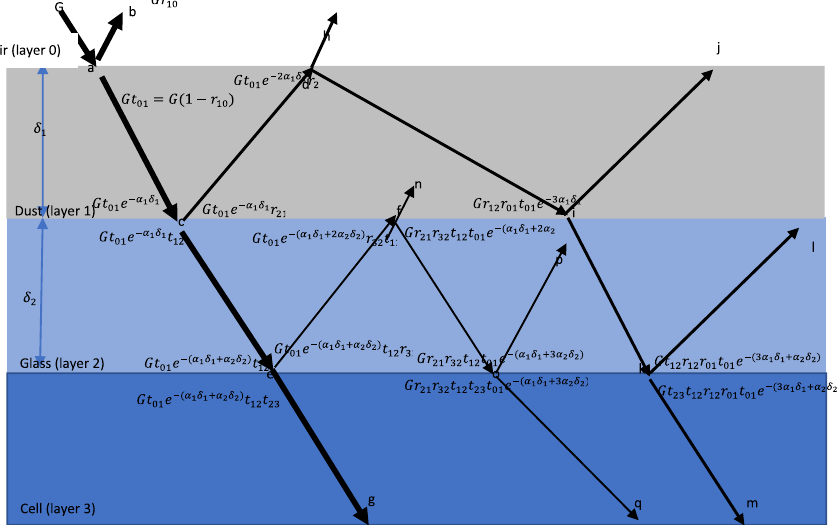
Fig. 2 Follow‑up of incident radiation with reflection and transmission through the three layers of the dusty PV module Propagation through the 3 layers of the module. Propagation through dust layer no. 1. Propagation through glass layer no.